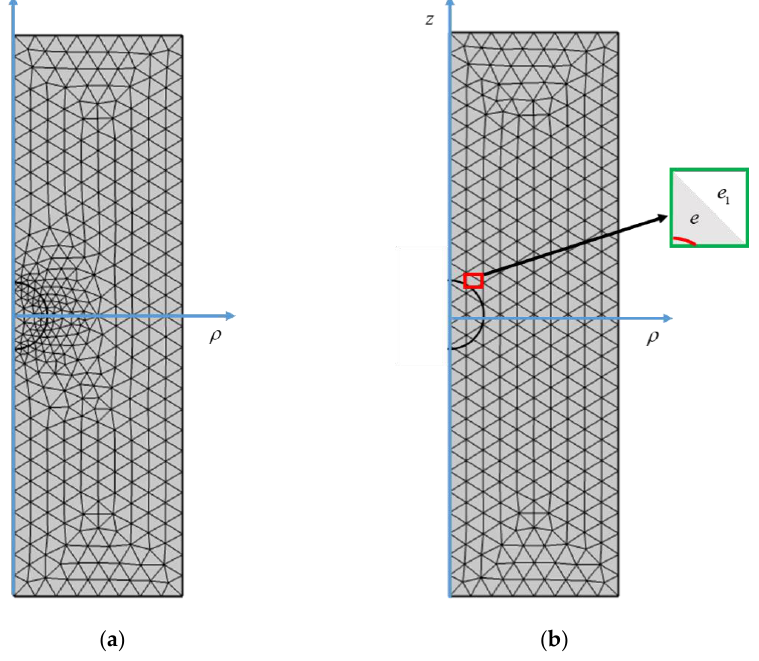
Figure 5. Meshing of the bubble in liquid nitrogen. ( a ) CFEM, ( b ) XFEM. Based on the mesh in Figure 5, the enlarged diagram is shown in Figure 2. The element E contains two sub-elements (e and e 1 ). The enrichment function of the chosen ele- ment can be obtained as Figures 6 and 7, which varies from different perspectives.